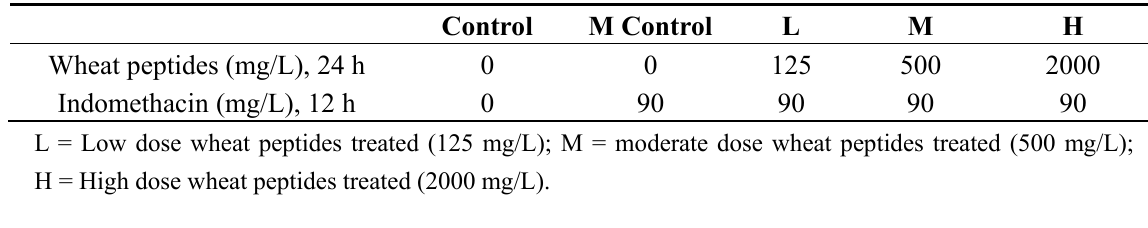
Table 1. Treatment of the wheat peptides and indomethacin in IEC-6